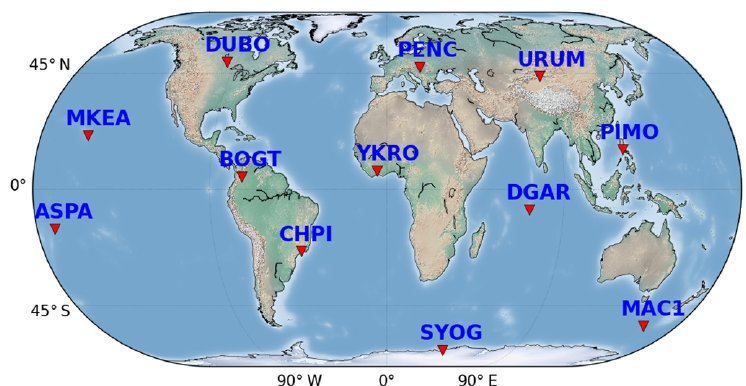
Figure 4. The geographical locations and the identifiers of the receiver sites used in the dSTEC analysis.